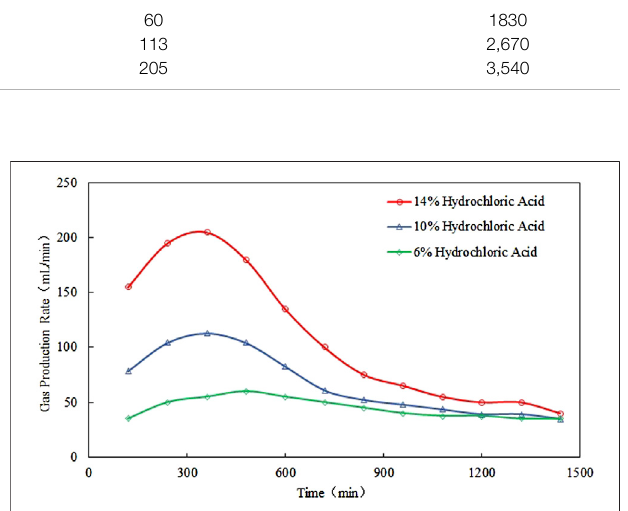
FIGURE6| Gasproduction